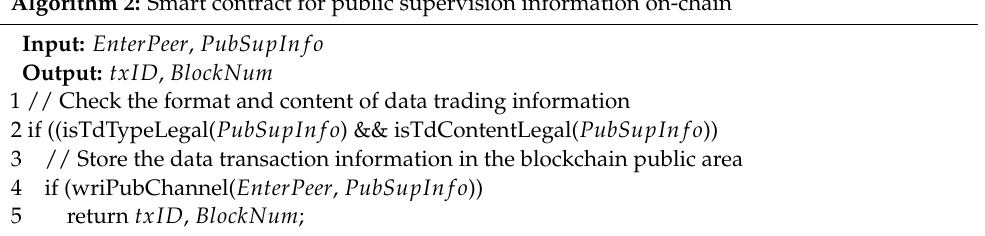
Algorithm 2: Smart contract for public supervision information